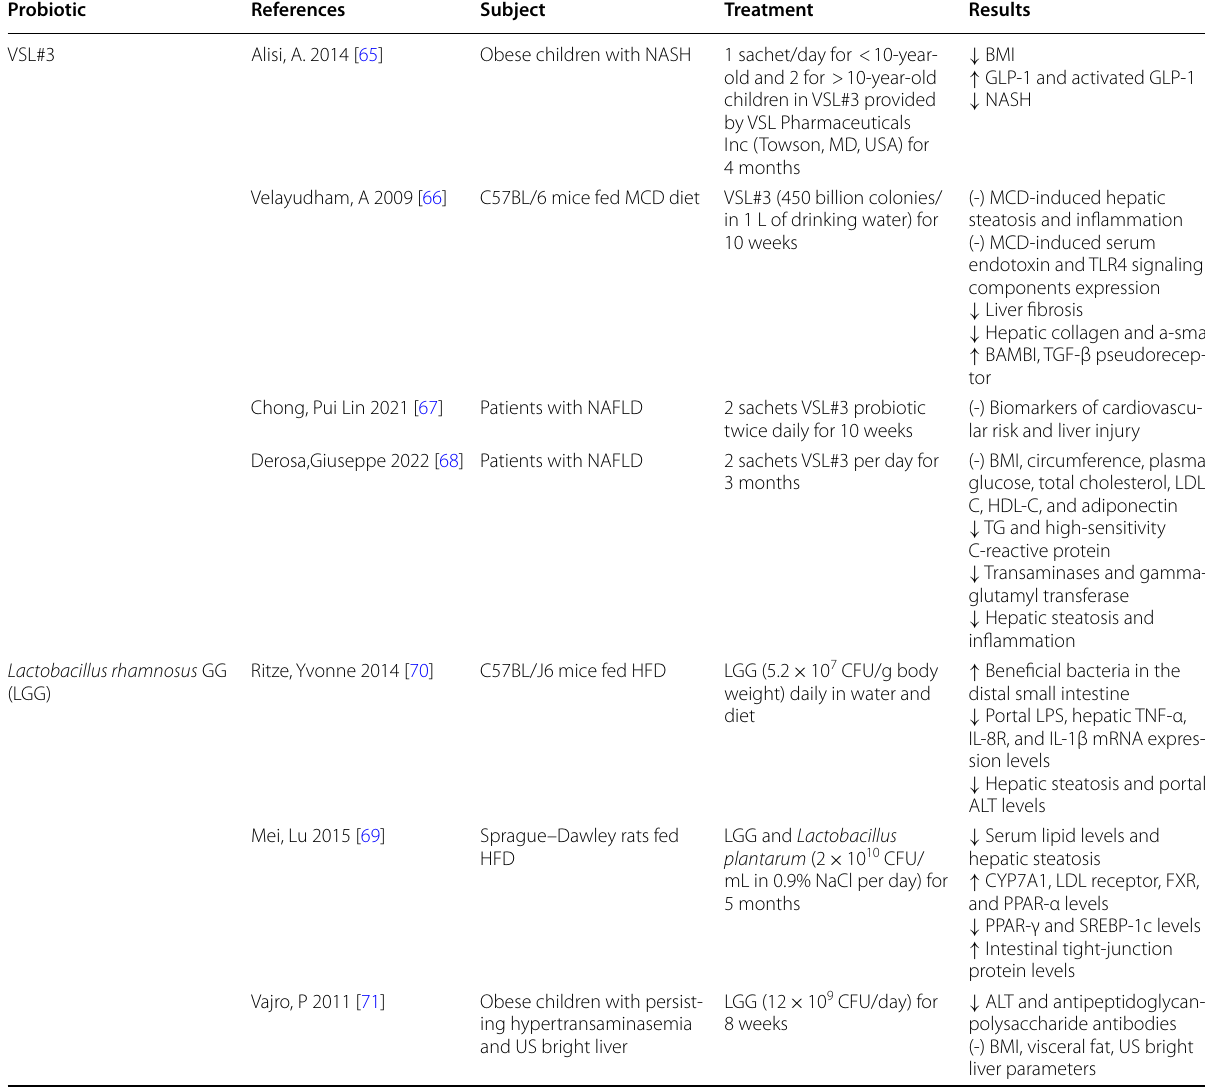
Table 3 Probiotics-incorporated studies on non-alcoholic fatty liver disease/non-alcoholic steatohepatitis